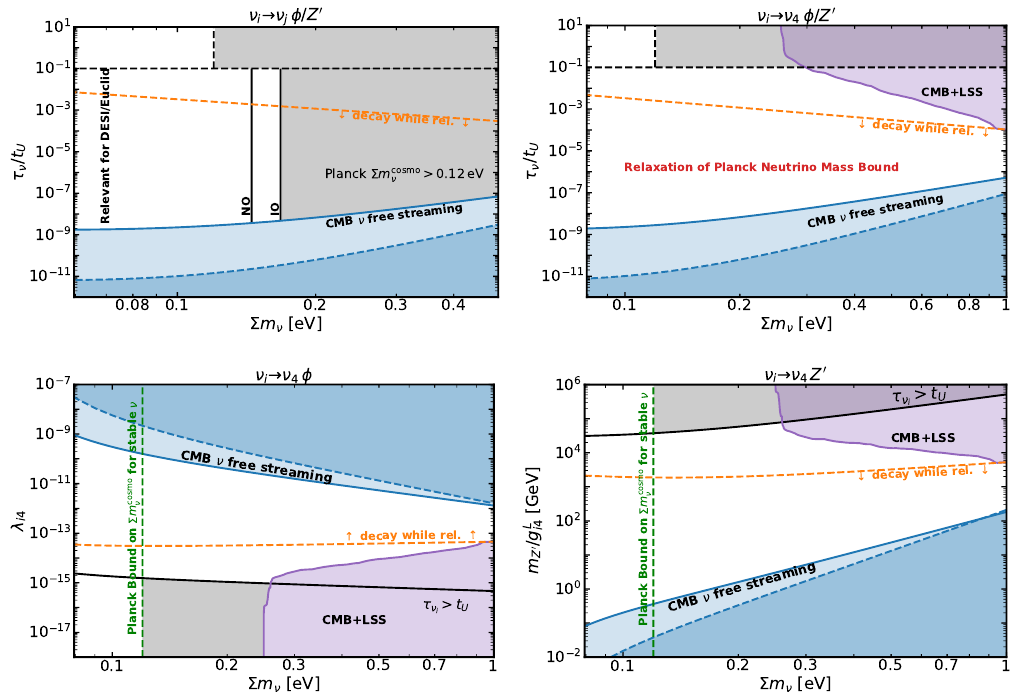
Figure 12 . Same as figure 3 ( upper panels ) and figure 6 ( lower panels ) but including the results from [116] (dashed blue lines), to be compared with the bounds presented in our analysis and derived from [22] (solid blue